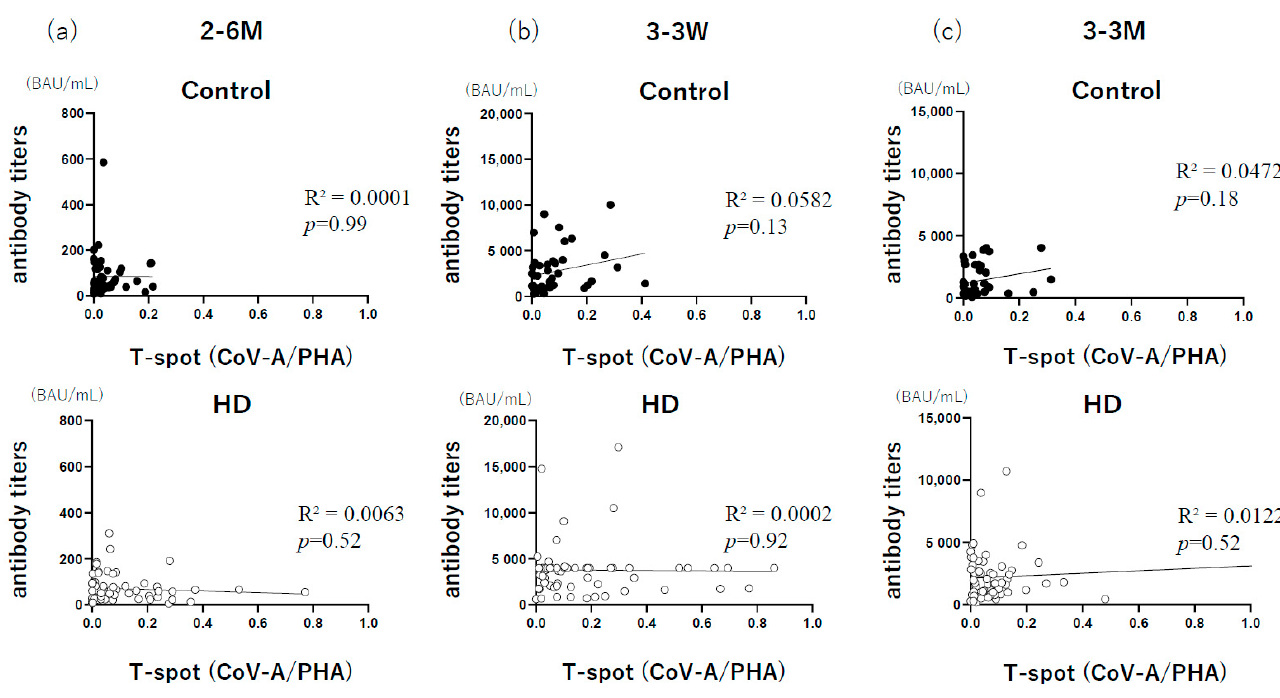
Figure 4. Correlation between the T-SPOT (CoV-A/PHA) results and antibody titers. The correlation between the T-SPOT COVID-19 results and antibody titers was examined at three-time points: ( a ) 6 months after the primary series, ( b ) 3 weeks after the booster dose, and ( c ) 3 months after the booster dose. 2–6 M, 6 months after the primary series; 3–3 W, 3 weeks after the booster dose; 3–3 M, 3 months after the booster dose. PHA, phytohemagglutinin. Table 4. Contingency table of T-SPOT results and SARS-CoV-2 IgG